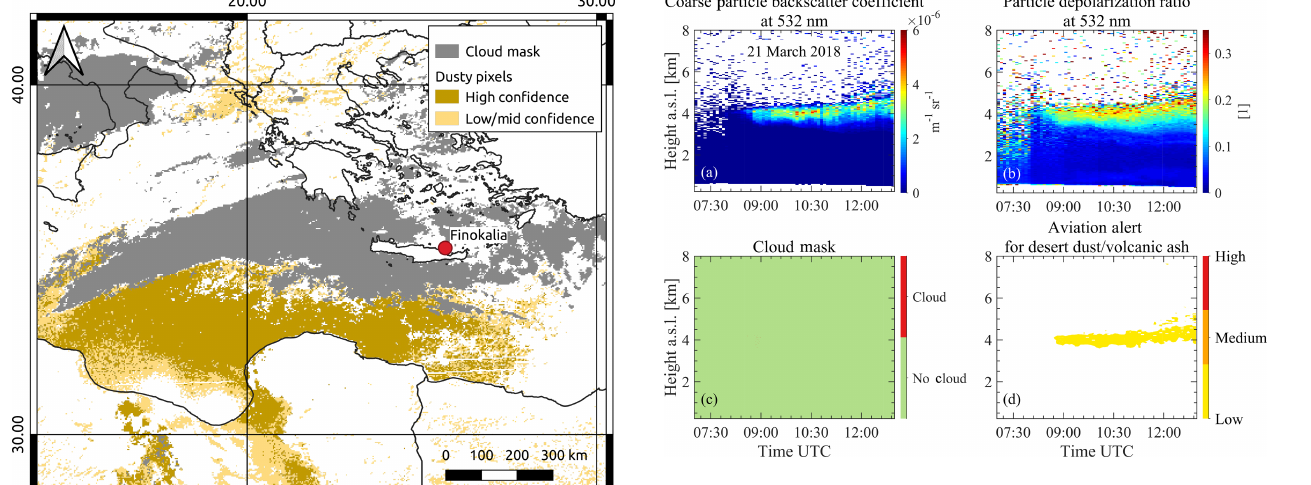
Figure 7. EARLINET observations at Finokalia on 21 March 2018: (a) the coarse particle backscatter coefficient at 532nm, (b) the par- ticle depolarization ratio at 532nm, (c) the cloud screening output, and (d) the alert for aviation. Note that the cloud screening product is given at its full resolution – i.e., the vertical resolution is 7.5m, and the temporal resolution is 30s – and all the other products have a resolution of 30m and 5min